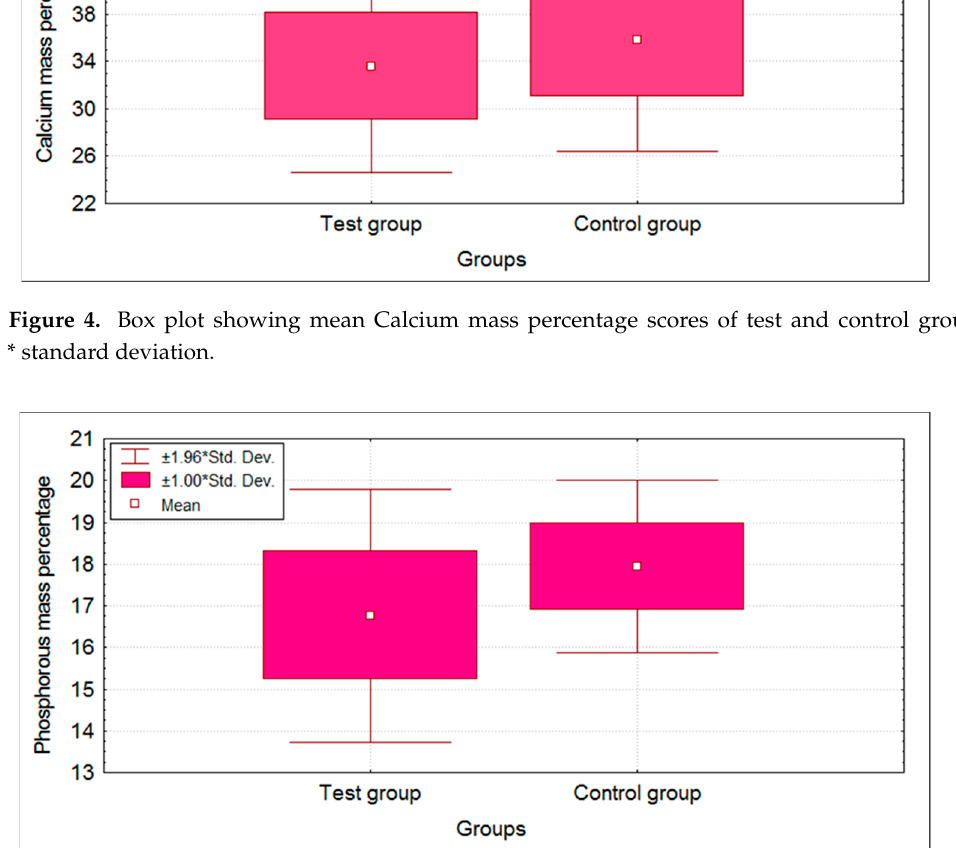
Figure 4. Box plot showing mean Calcium mass percentage scores of test and control groups. * standard deviation Figure 5. Box plot showing mean Phosphorous mass percentage scores of test and control groups. * standard deviation * standard